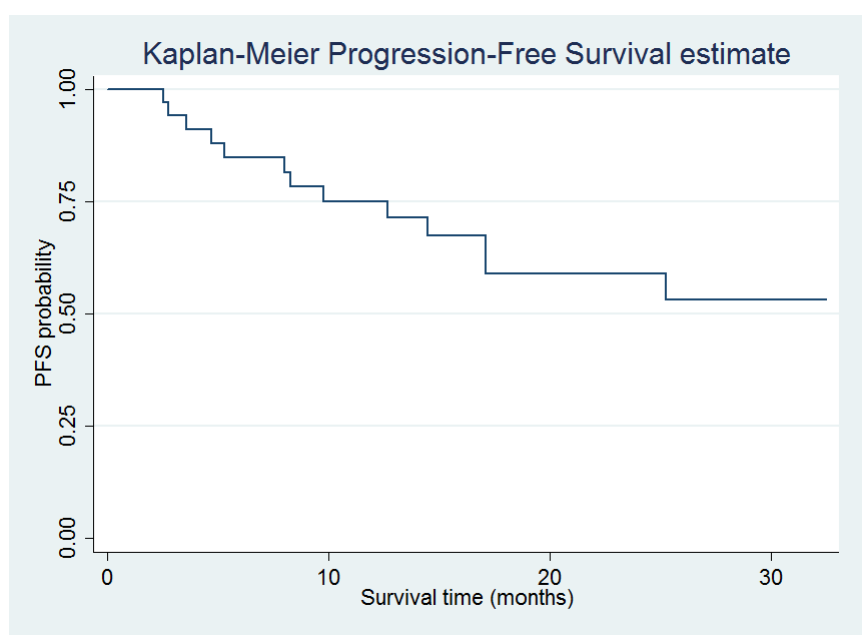
Figure 1. Kaplan–Meier Curve of progression-free survival.